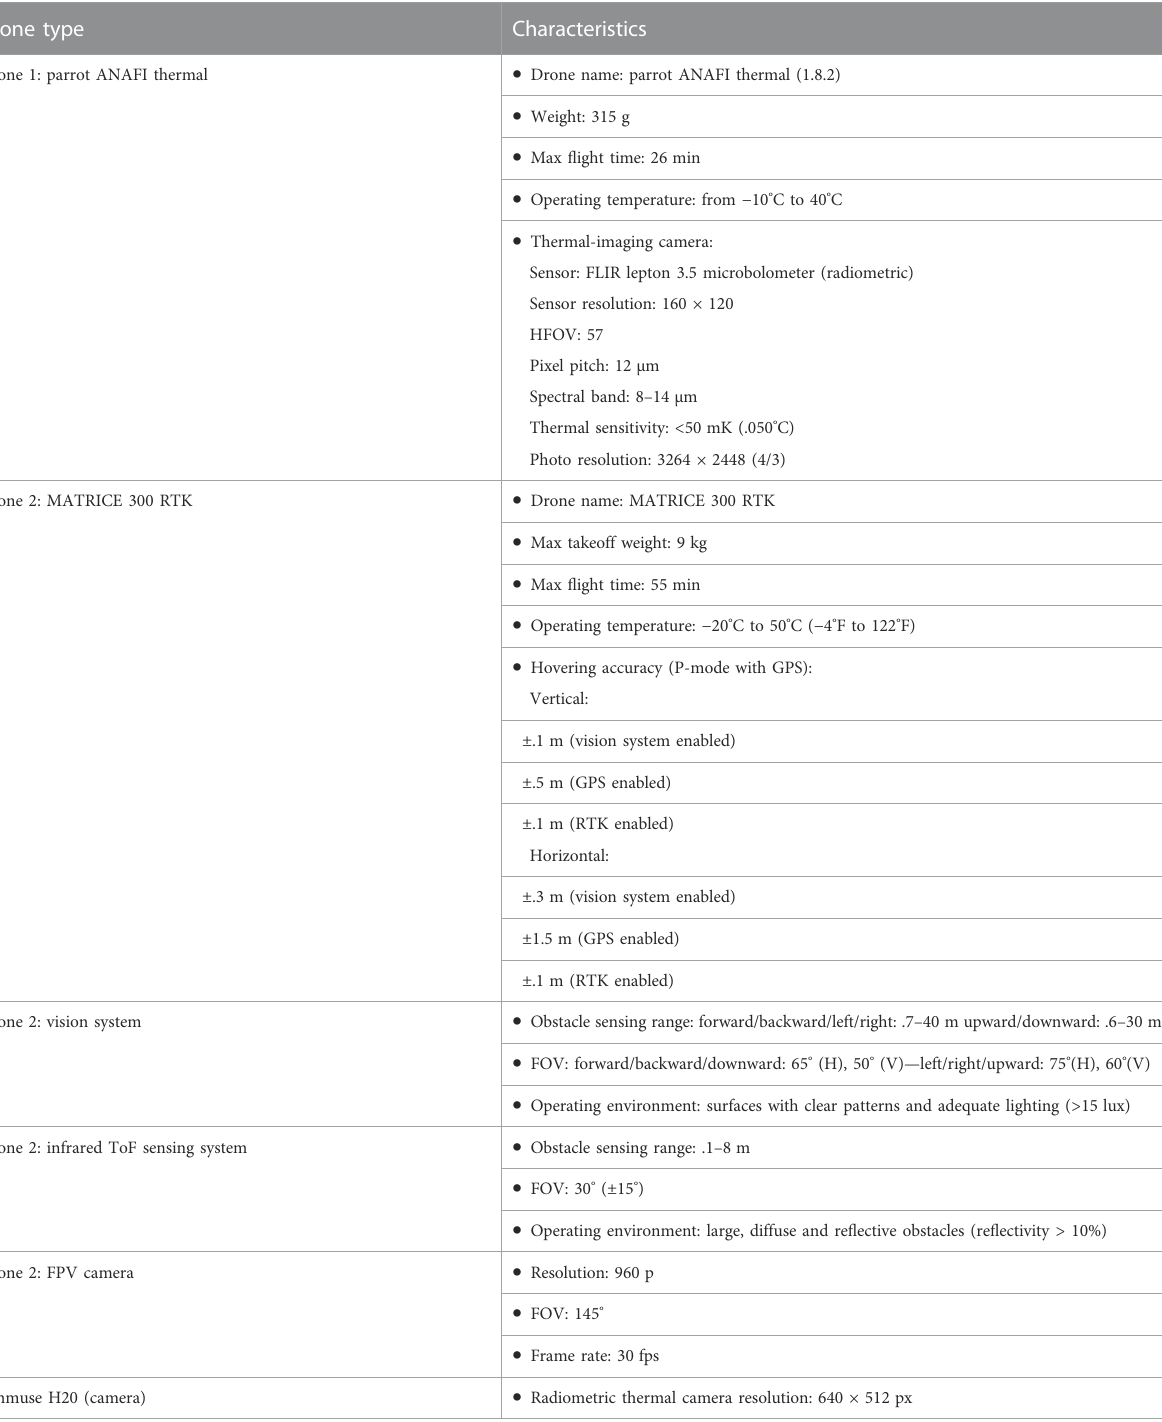
TABLE 1 The characteristics of the drones and cameras employed in this research